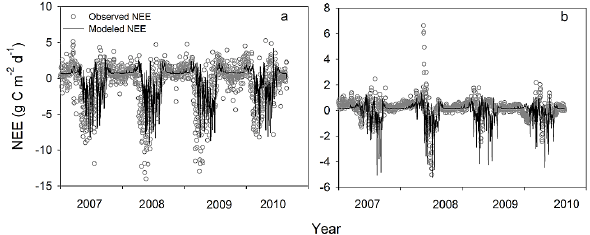
Fig. 1. Comparisons between observed daily NEE from eddy flux data and modeled daily NEE in the Konza tallgrass prairie (a) and the Sevilleta desert grassland (b) from 2007 to 2010. Overall, the TECO model can reproduce observed